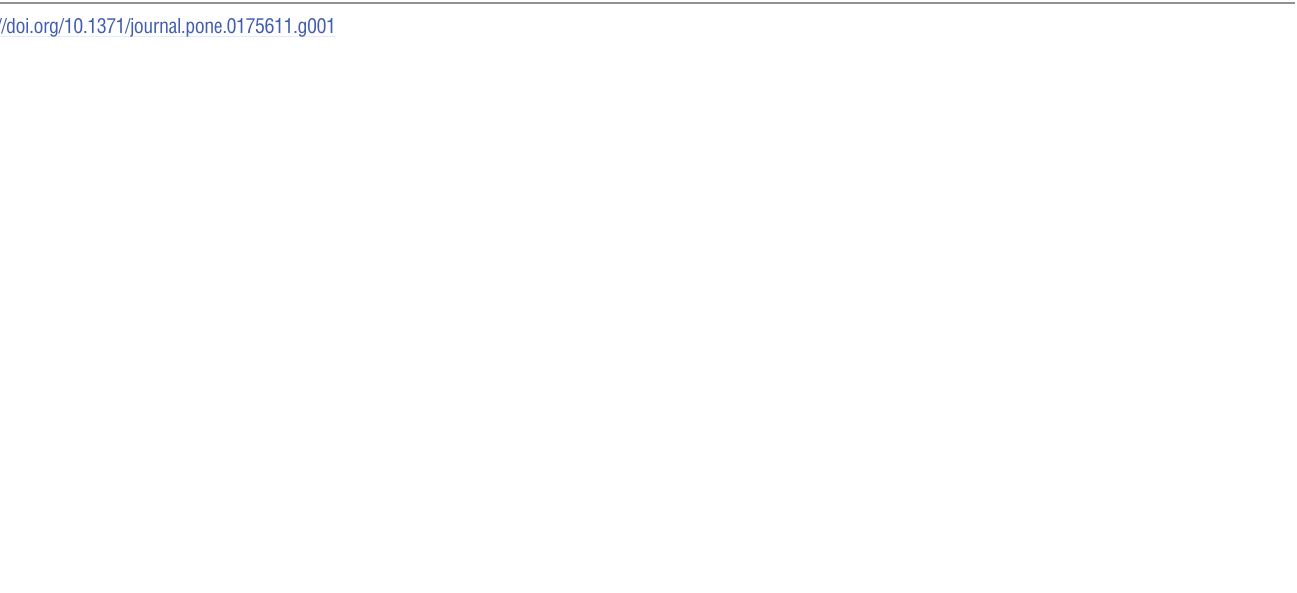
Fig 1. The relation between motor function and leptin SDS in terms of SMA type, showing that the lower the overall motor function, the higher was the risk for elevated leptin levels. Vertical lines in bold at -2 SD and +2 SD indicatethe reference range for leptin SDS. As a consequence, lower motor function is linked to high leptin-SDS independent of SMA